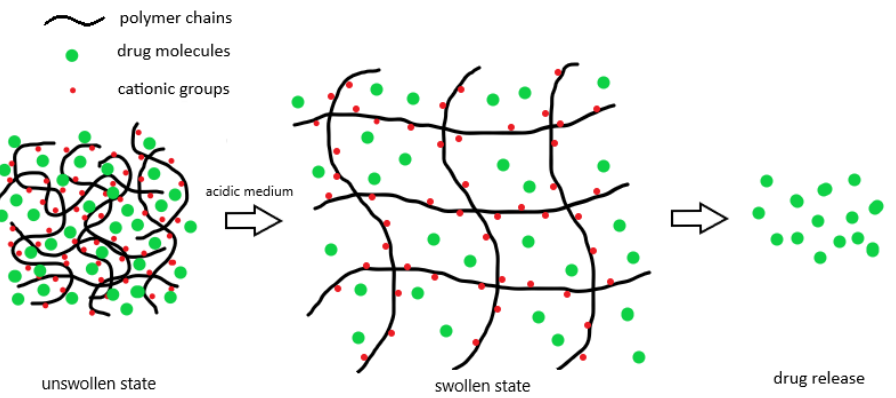
Figure 2. The hydrogels composed of cationic polymers are swollen more in acidic medium to facil- itate drug release from their